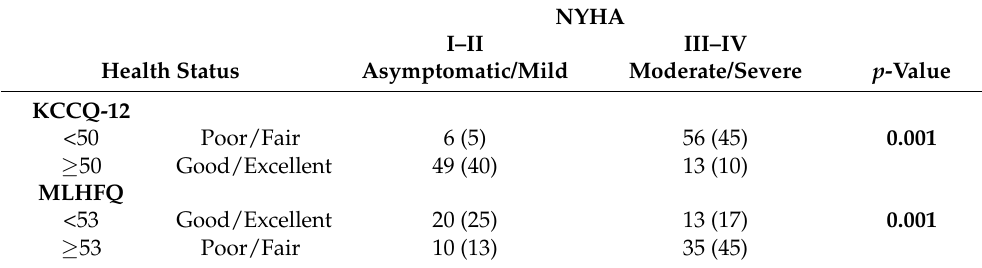
Table 3. Analysis of associations between NYHA, KCCQ-12, and